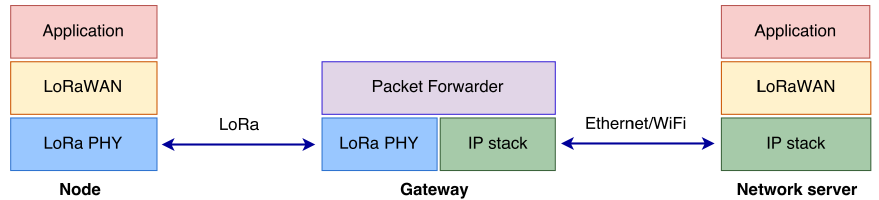
Figure 1. Modules in FLoRa and the corresponding protocol stack